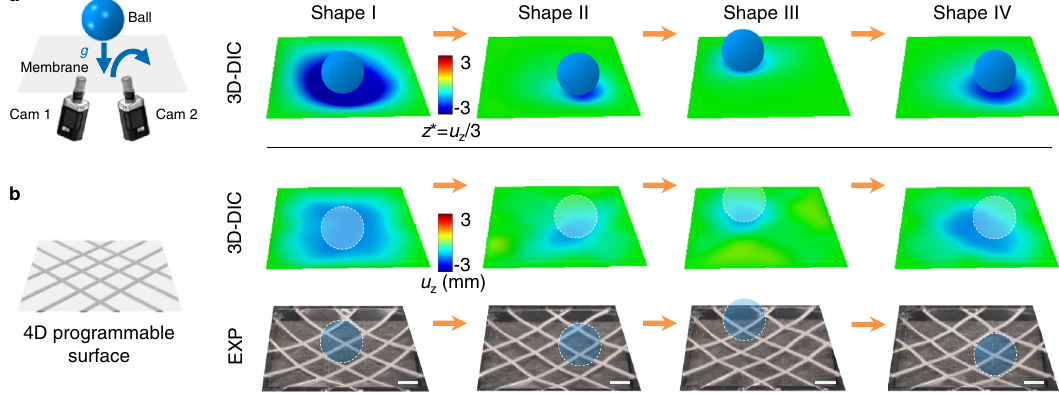
Fig. 4 4D programmability. a A dynamic shape changing sequence associated with dropping a ball onto a test membrane under the action of gravity, as captured by 3D-DIC. b Experimental results (3D-DIC and optical images) of the programmable surface reproducing the dynamic physical process in a , but without the ball. Scale bars, 5